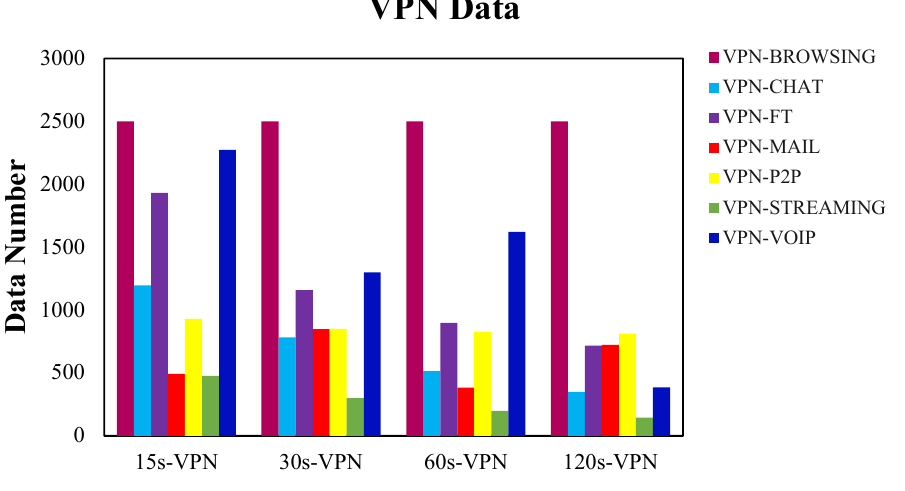
Figure 12. VPN-encrypted traffic data statistics.